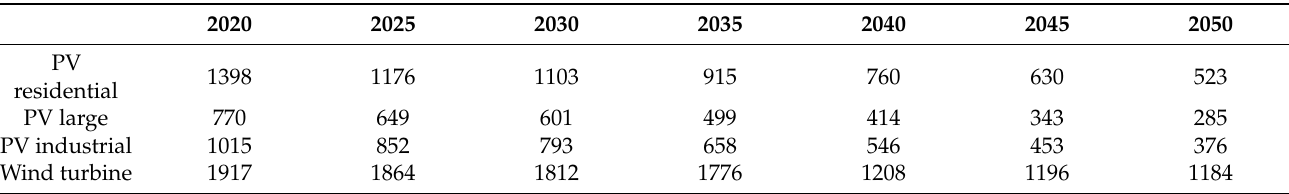
Table 1. Estimated investment cost of PV and wind turbines (EUR 2015/kWp).